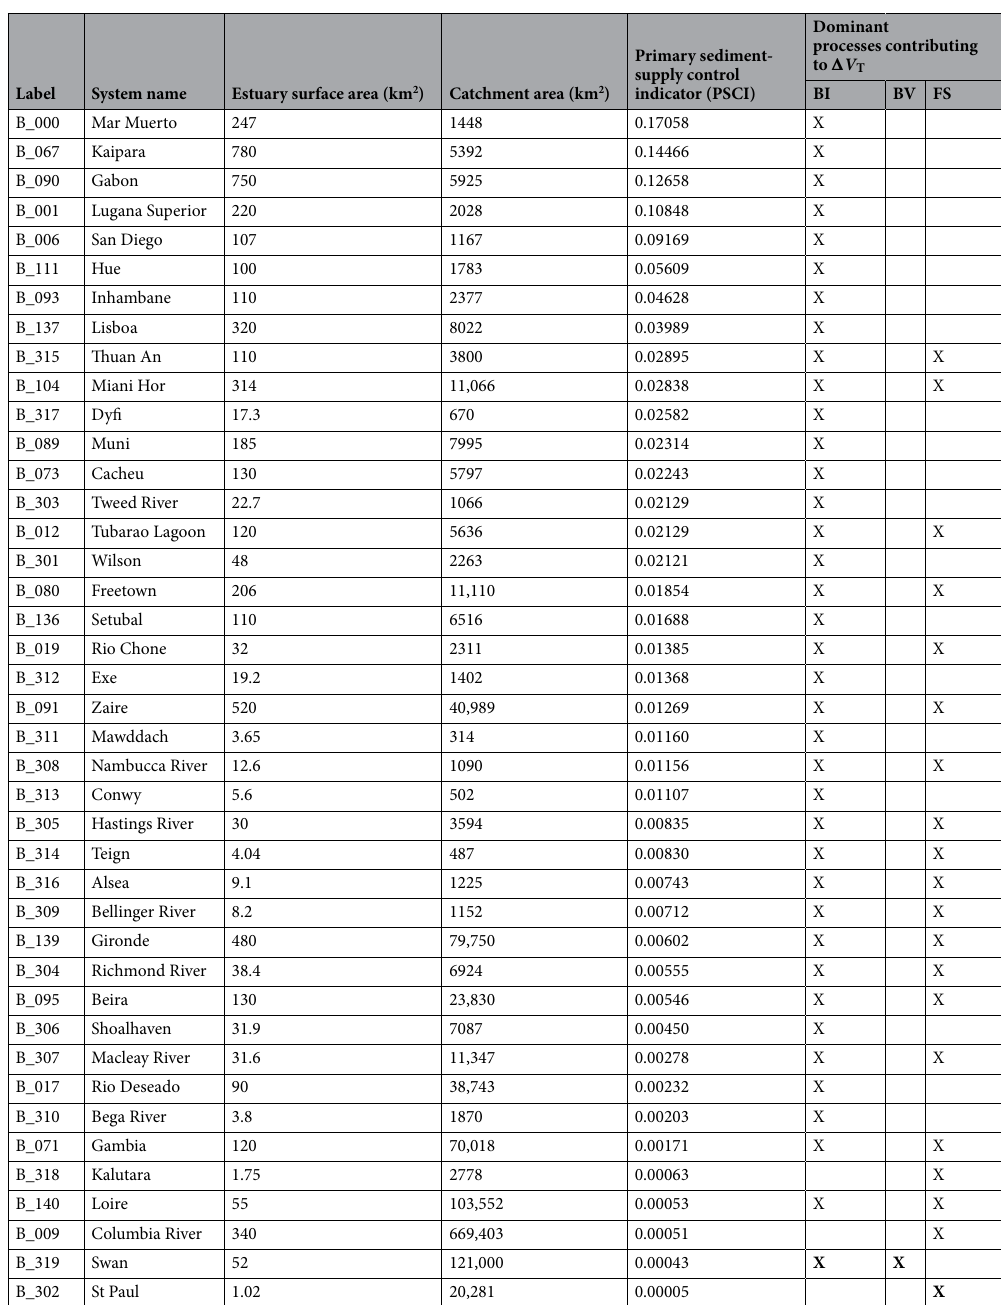
Table 1. Comparison of the primary sediment-supply control indicator (PSCI) and the dominant physical processes contributing to the total sediment volume exchange ( (cid:31) V T ) at the 41 catchment-estuary-coastal systems considered. PSCI is the ratio between the estuary surface area and the river catchment area. Dominant contributing processes to the variation of (cid:31) V T are identified by examining the variations of the projected 50th percentile values of projected (cid:31) V T and the contributing processes (i.e., basin infilling (BI), basin volume change (BV), and fluvial sediment supply (FS)) over the 2020–2100 period (See Figure S1 and S2 of the Supplementary